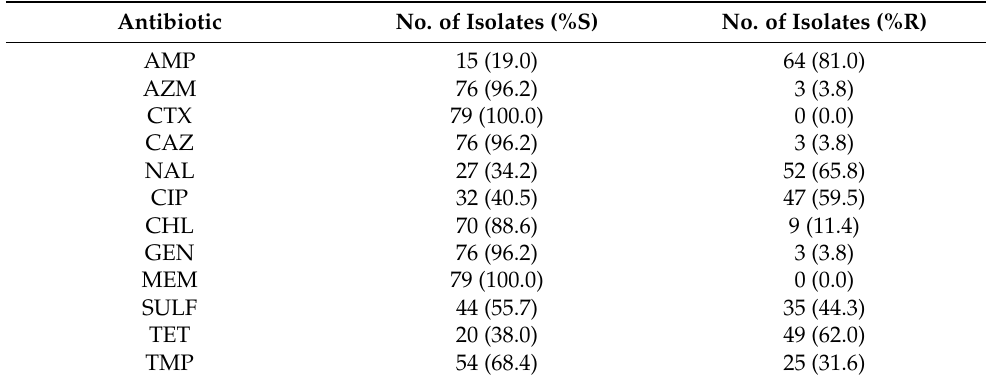
Table 4. Susceptibility to antibiotics of E. coli isolated from feces of egg laying and breeding hens according to EUCAST [56] and CLSI [57] parameters.